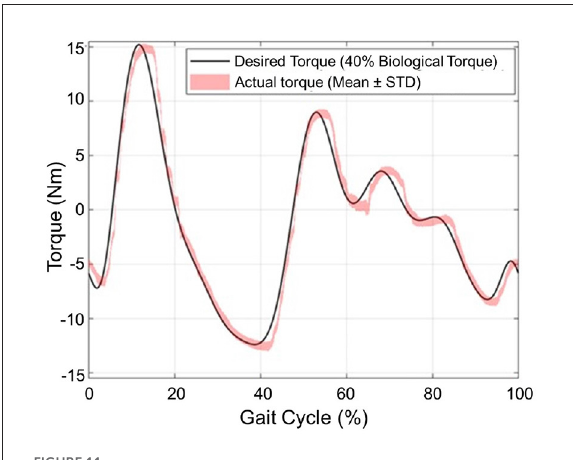
FIGURE11 Tracking torque performance of the 16 Nm peak torque, which is about 40% knee torque assistance required during human